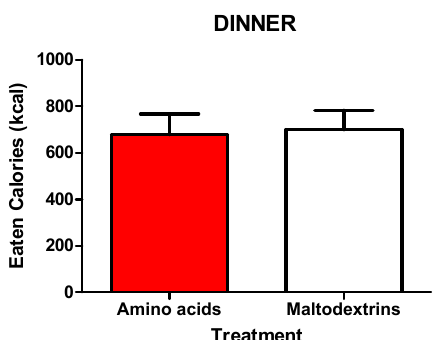
Figure 5. Intake of calories of food (i.e., difference between pre- and postdinner values) in obese adolescents after ad libitum dinner (consumed within 20 min starting at T555), administered with amino acid mix (L-arginine, L-leucine, L-glutamine, and L-tryptophan) or placebo (maltodextrins) at T0. See the text for further details. Values are expressed as means ± SDs. The number of subjects was 14. A Student’s t- test for paired data was used.